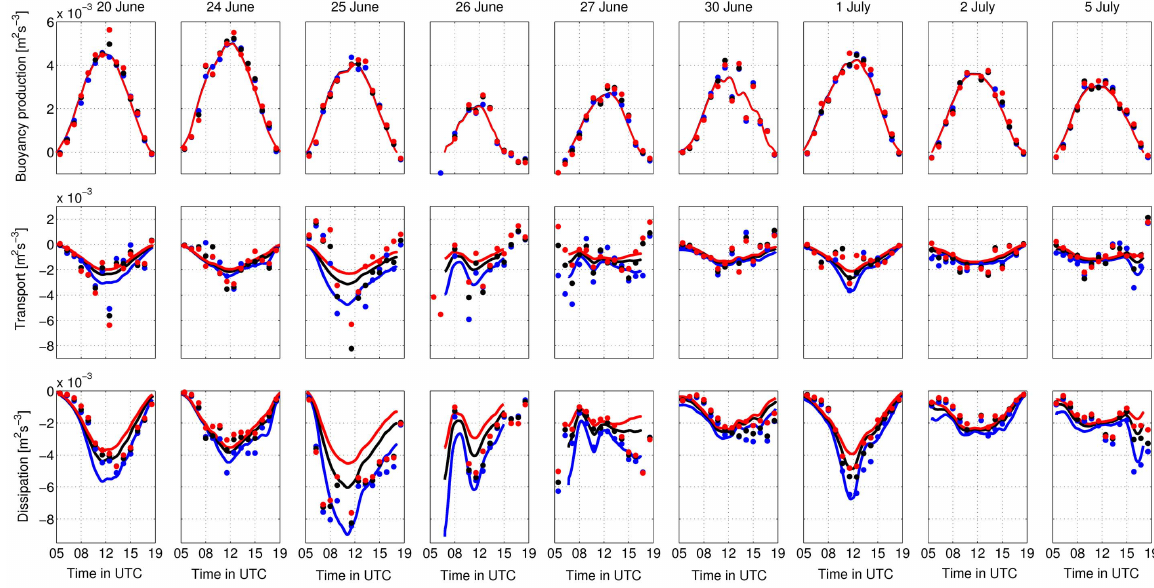
Figure 9. The upper row shows the observed hourly averaged buoyancy production at 2.23, 5.27 and 8.22m (filled blue, black and red circles) and the corresponding model buoyancy production (lines). The middle row shows the corresponding observed and modeled values for transport. The lower row shows the observed and modeled values of